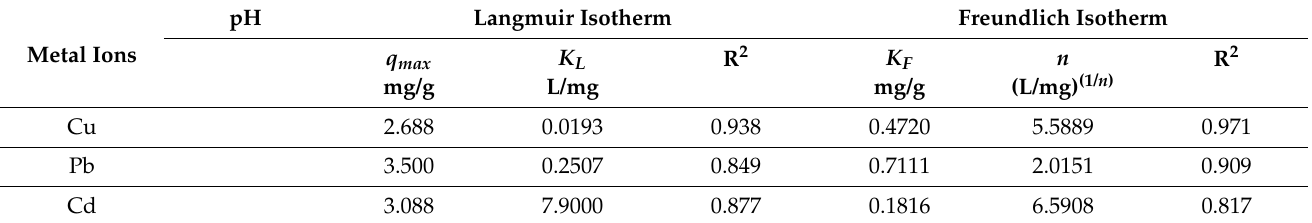
Table 4. Isotherm model constants and correlation coefficients for metal ions